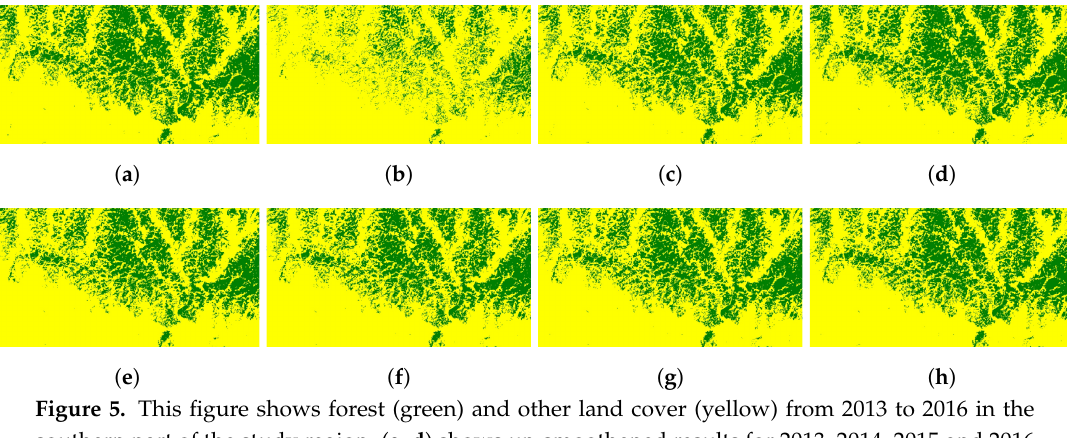
Figure 5. This figure shows forest (green) and other land cover (yellow) from 2013 to 2016 in the southern part of the study region. ( a – d ) shows un-smoothened results for 2013, 2014, 2015 and 2016 respectively. Similarly, ( e – h ) shows smoothened results for 2013, 2014, 2015 and 2016 respectively. A huge improvement can be seen in 2014. These are the final results generated from the best primitive set, i.e., picking best primitives after applying different algorithms on each primitive.